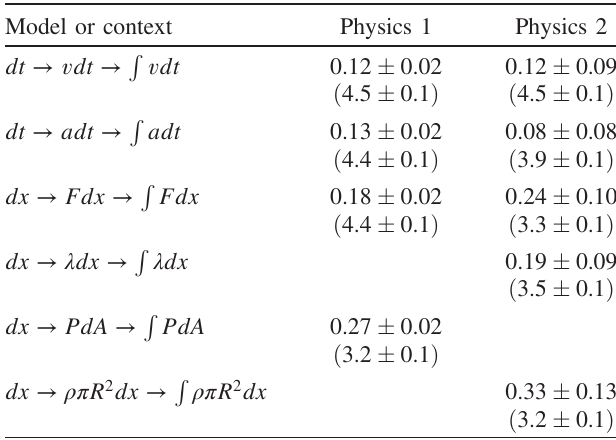
TABLE V. Standardized indirect effects ab estimated with 1 standard error for each model or context separately, where each R vdt . Later, an independent or model is of the form dt → vdt → unrelated sample of early-semester Physics 2 students reported familiarity for each integral shown ( “ 1 ” to “ 5, ” higher number indicates more familiar); familiarity is displayed in parentheses with 1 standard error.